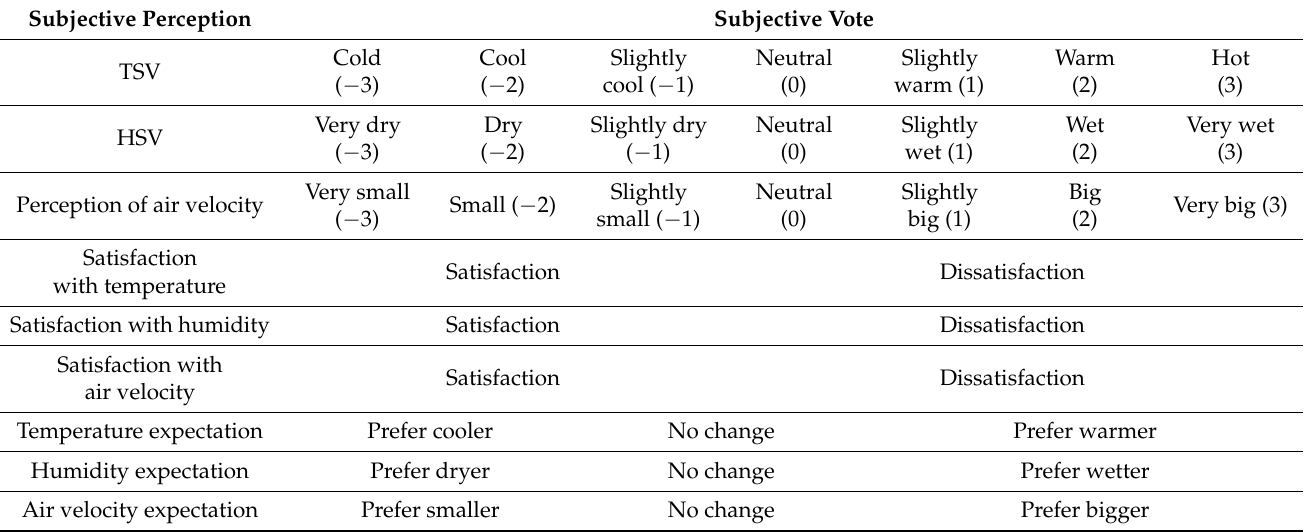
Table 3. Subjective vote scale.